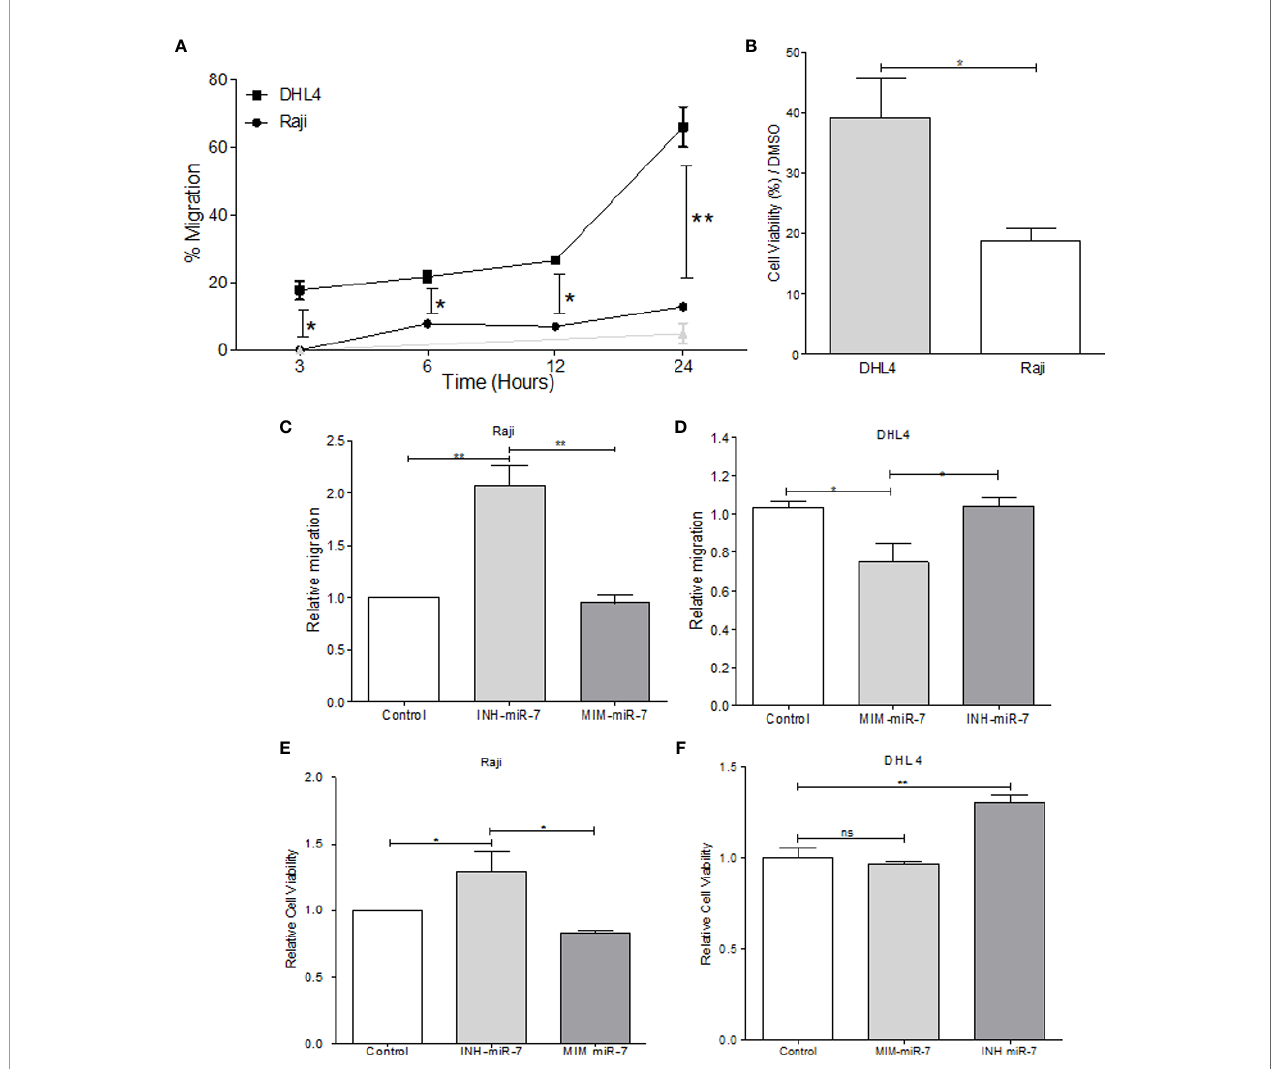
FIGURE 3 | miR-7 play a role in the migration and chemoresistance in non-Hodgkin lymphoma (NHL) cell lines. (A) migration assay in Transwell ™ chambers. Percent of total cell numbers was determinate in Raji and DHL4 cells at 3, 6, 12, and 24 h. (* p < 0.05, ** p < 0.001). (B) Chemoresistance was evaluated by cellular viability after CDDP treatment (330 µM). Percent of viability was reported for Raji and DHL4 cell line (* p < 0.05). (C, D) Migration assay in the Raji cell line transfected with INH-miR-7 or MIM-miR-7 and DHL4 cells transfected with the MIM-miR-7 or INH-miR-7 as well, respectively (* p < 0.05) was done. (E, F) Chemoresistance in Raji cell line transfected with the INH-miR-7 or MIM-miR-7 and DHL4 cells transfected with the MIM-miR-7 or INH-miR-7, respectively (* p < 0.05 ) was done. Results of three independent experiments are